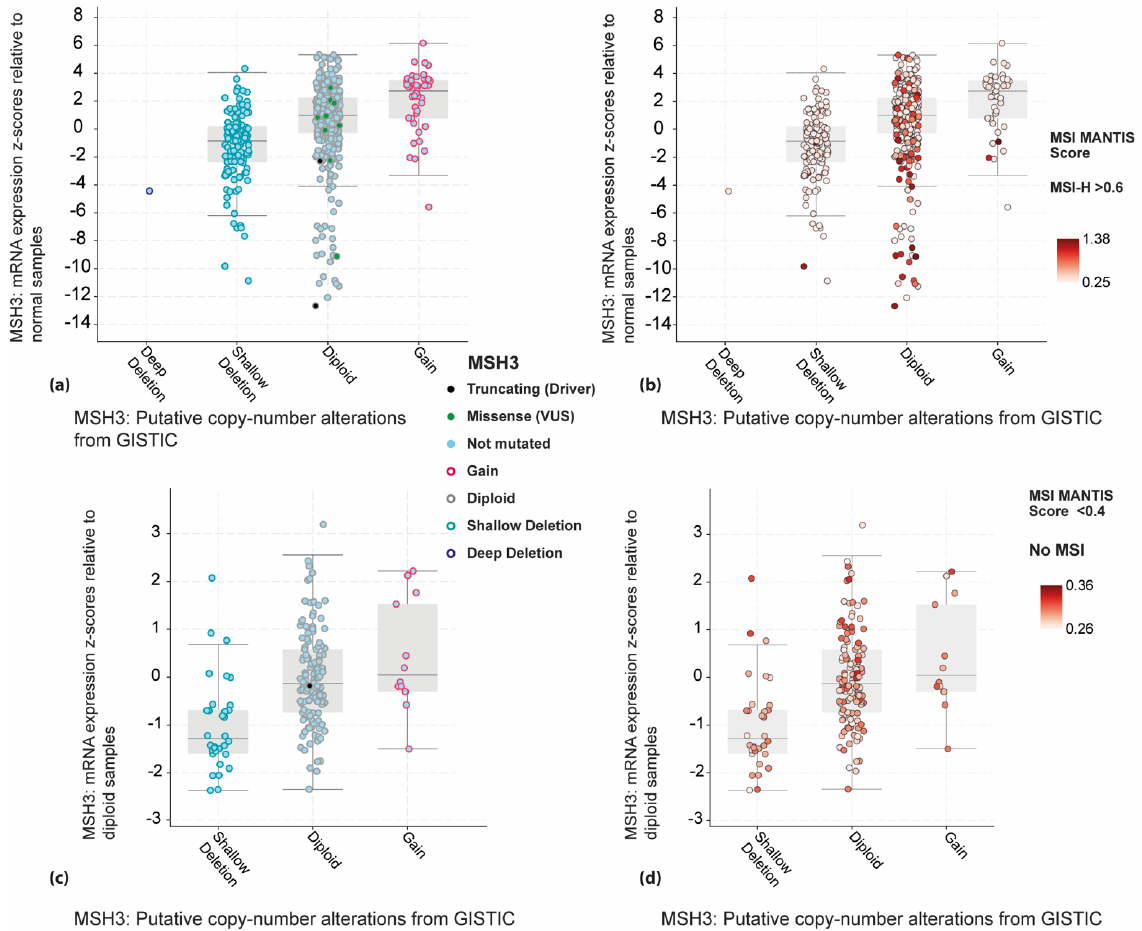
Figure 3. Genomic data from 524 colorectal and 168 pancreatic adenocarcinomas that were profiled for MSH3 gene mutations, copy number alterations, mRNA expression and MSI MANTIS score in the TCGA PanCancer Atlas [32–35]. ( a ) Colorectal cancers have MSH3 truncating mutation in 0.4% (2/524), one copy deletion in 24% (128/524), deep deletion in 0.2% (1/524), copy gain in 8% (41/524) and mRNA expression z-score (relative to normal samples) less than 2 in 17% (87/524) of the patients. The z-score for each tumour specimen indicates the number of standard deviations away from the